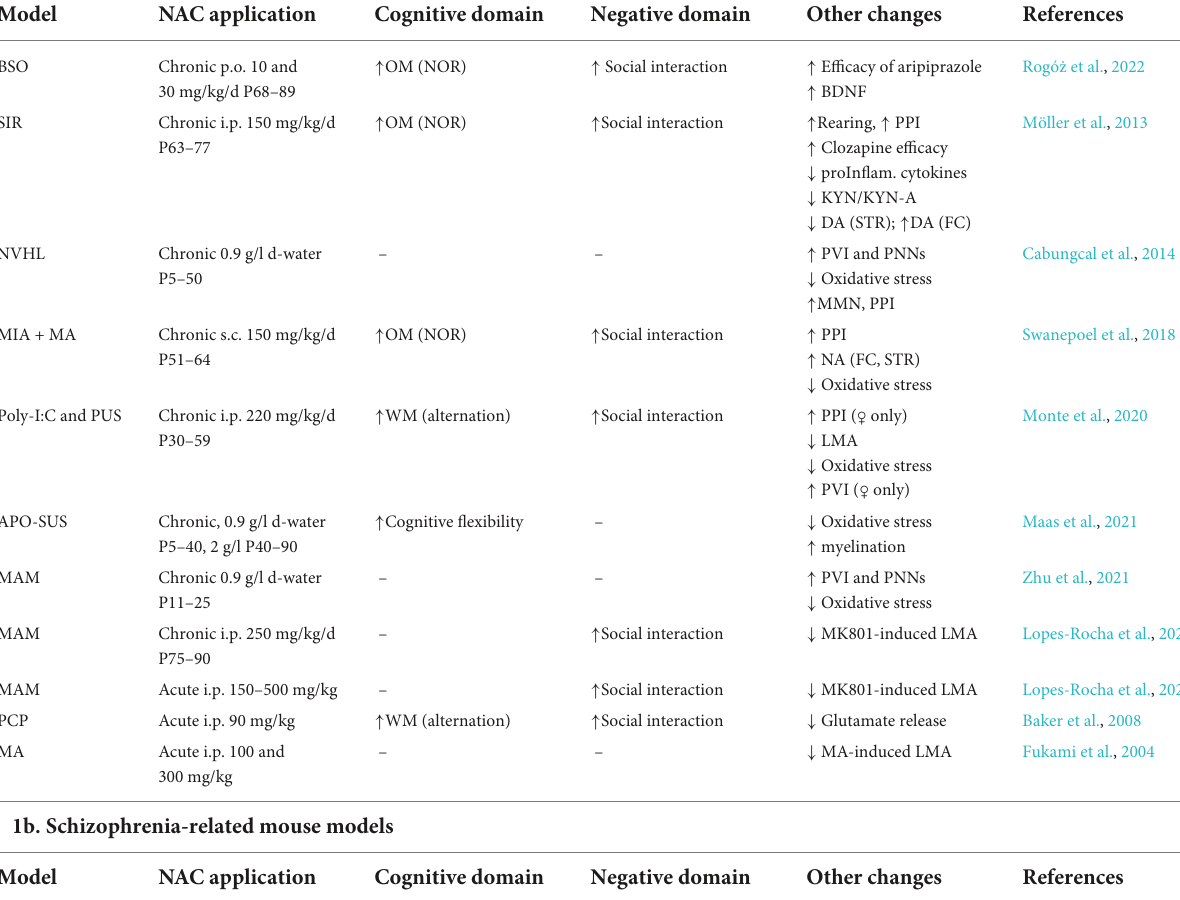
TABLE 1 N-acetylcysteine-induced therapeutic effects in psychiatrically relevant rodent